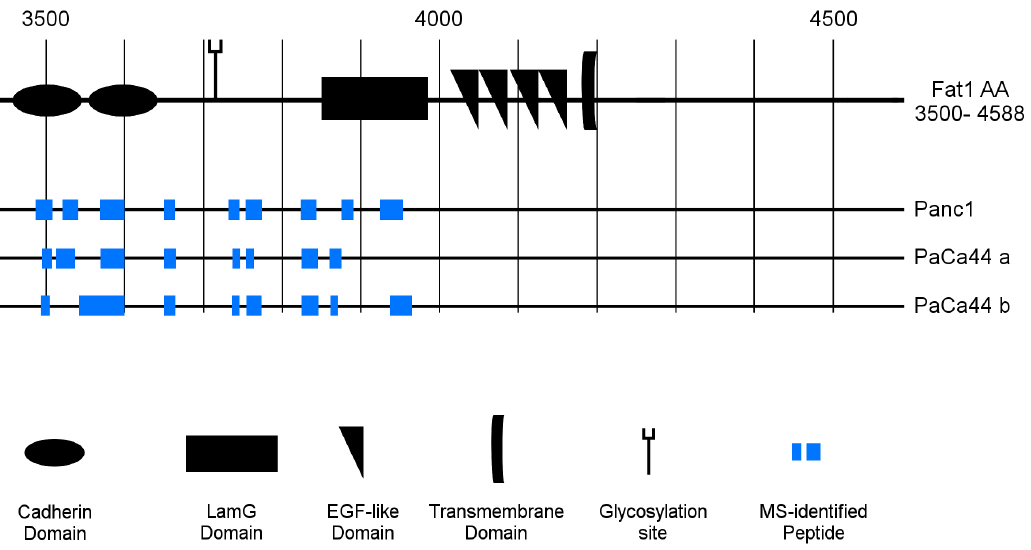
Figure 2. Mass spectrometric analysis of secretomes exclusively indicates peptides derived from the extracellular domain of Fat1. Mass spectrometric analyses were performed with all six secretomes and Fat1 specific peptides were detected beginning near the amino terminus down to and including the EGF domain (see file S1 for details). Shown here are alignments of Fat1 specific peptides from three exemplary results with high sequence coverage in the section of amino acids 3500 down to the C-terminus at AA4588 (according to HPRD).